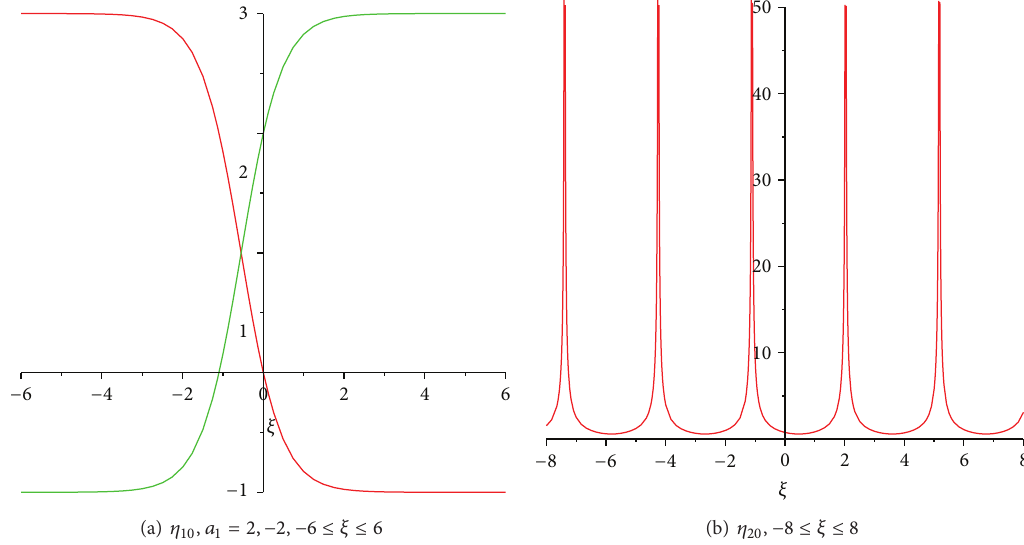
Figure 5: 2D figures of solution 𝜂 10 (𝜉) in (53) with 𝑎 0 = 1 , 𝐴 1 = 2 , 𝐴 2 = 1 , and 𝛿 = −1 and 𝜂 20 (𝜉) in (70) with 𝑎 1 = 1 , 𝐴 1 = 2 , 𝐴 2 = 1 , and 𝛿 = 1